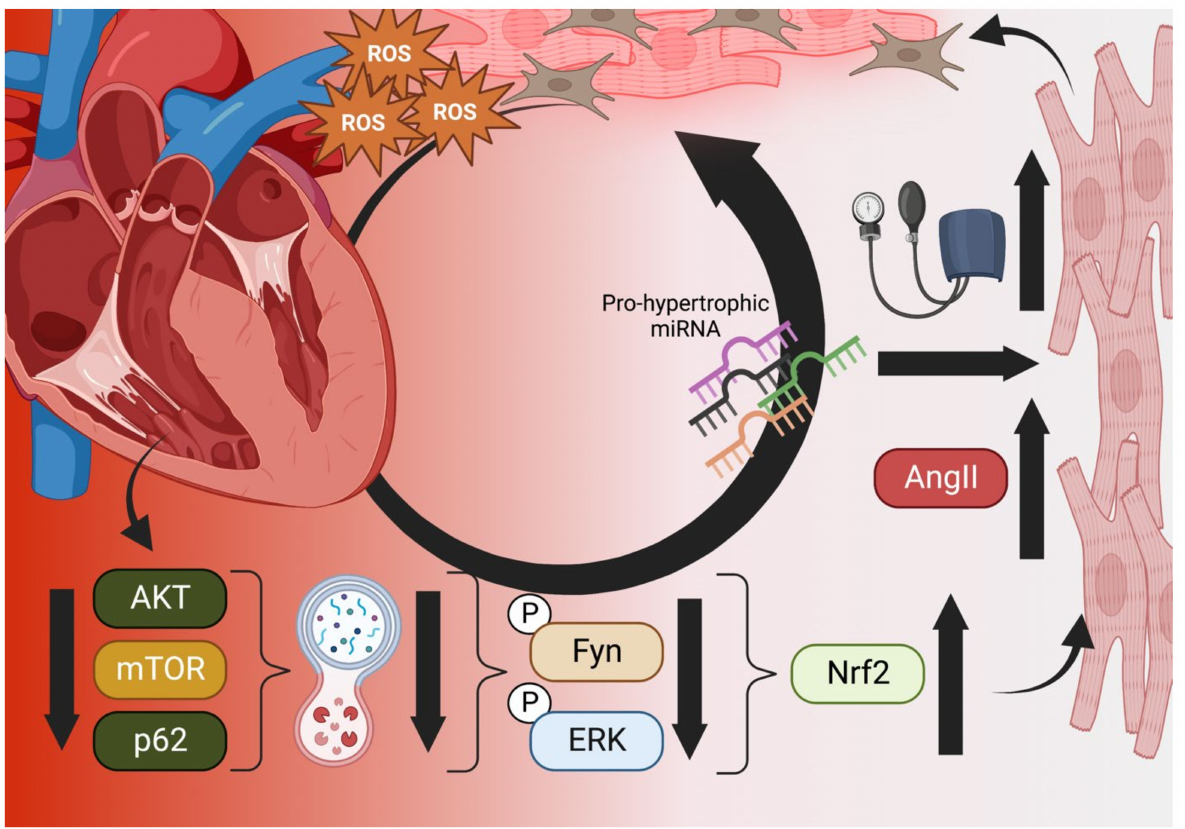
Figure 1. The Vicious Cycle of Nrf2 in Cardiac Hypertrophy. Aged and failing hearts have dys- functional autophagy ( bottom ), which cannot downregulate Nrf2 transcription of Angiotensinogen and AngII, increasing blood pressure and mechanical induction of hypertrophy, pro-hypertrophic miRNA, necrosis, and fibroblast activation ( right ). Hypertrophic cells increase ROS output and decompensation within the heart occurs, increasing the ischemic microenvironment and generating even more ROS in a vicious cycle ( top ) [71,72]. Created in